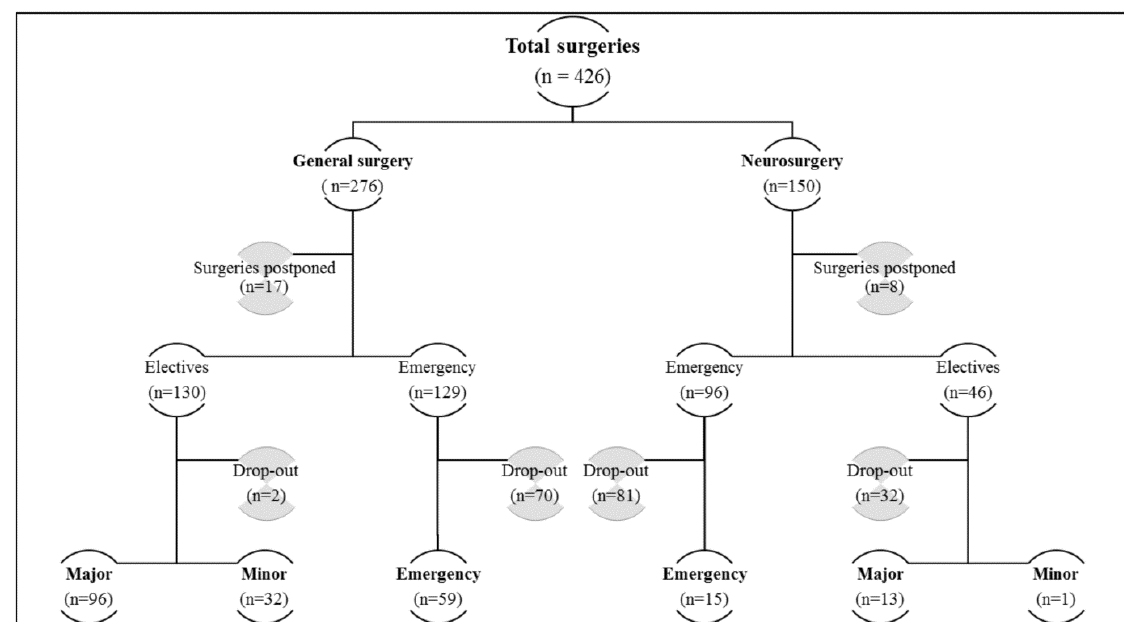
Figure 1. Detailed flowchart of patient recruitment throughout the study period displaying the drop-out of the patients who were lost to follow-up and hence were excluded.